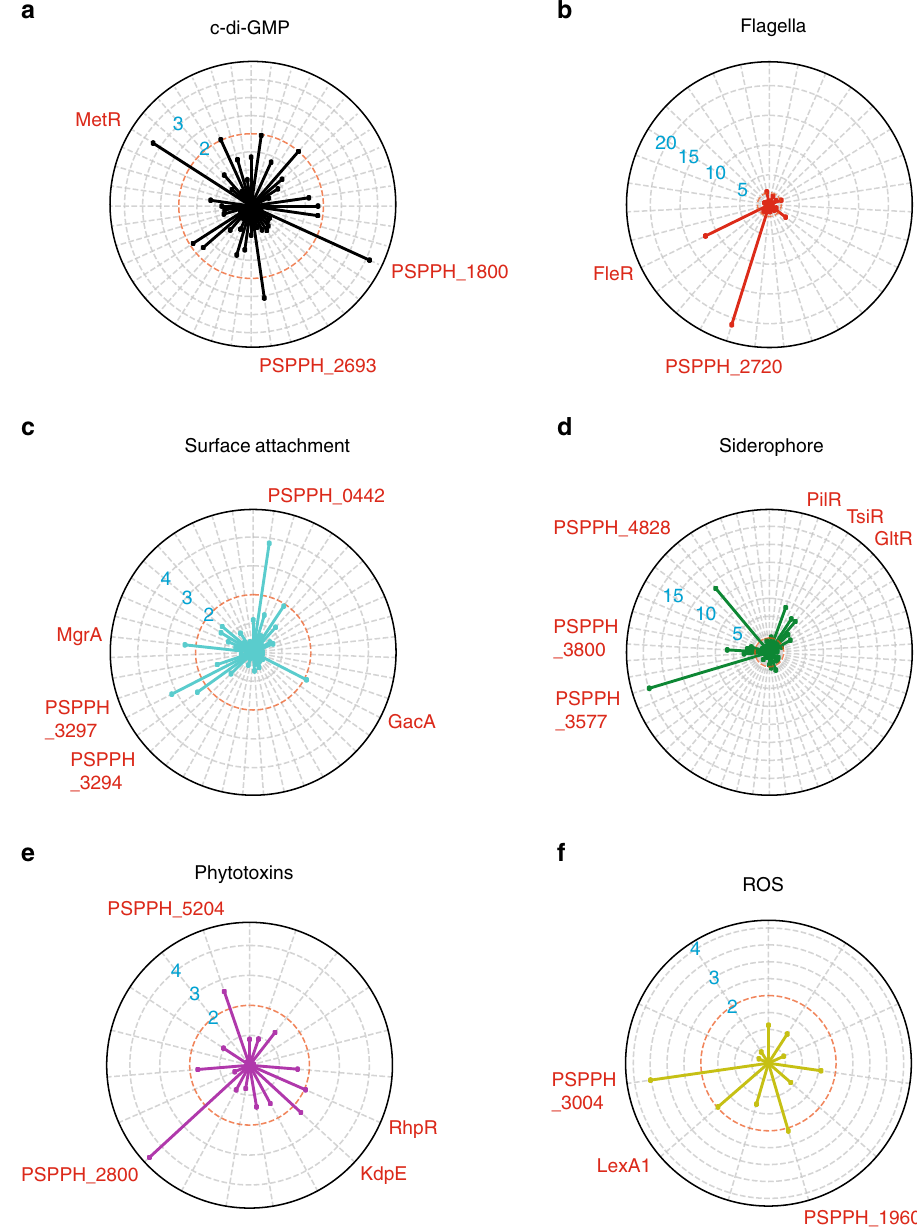
Fig. 4 Master regulators in non-T3SS virulent pathways. a – f Radar plots show the putative master regulators identi fi ed in six different non-T3SS virulent pathway, including c-di-GMP ( a ), fl agella ( b ), surface attachment ( c ), siderophore ( d ), phytotoxins ( e ), and SOD ( f ). Each radiation line represents a master regulator, and the radial length of the thick colored line is − log10 ( P value), representing the signi fi cance of the enrichment of the TF targets within each pathway. The names of master regulators are marked in red-type face. Also see Supplementary Data 3. TF transcription